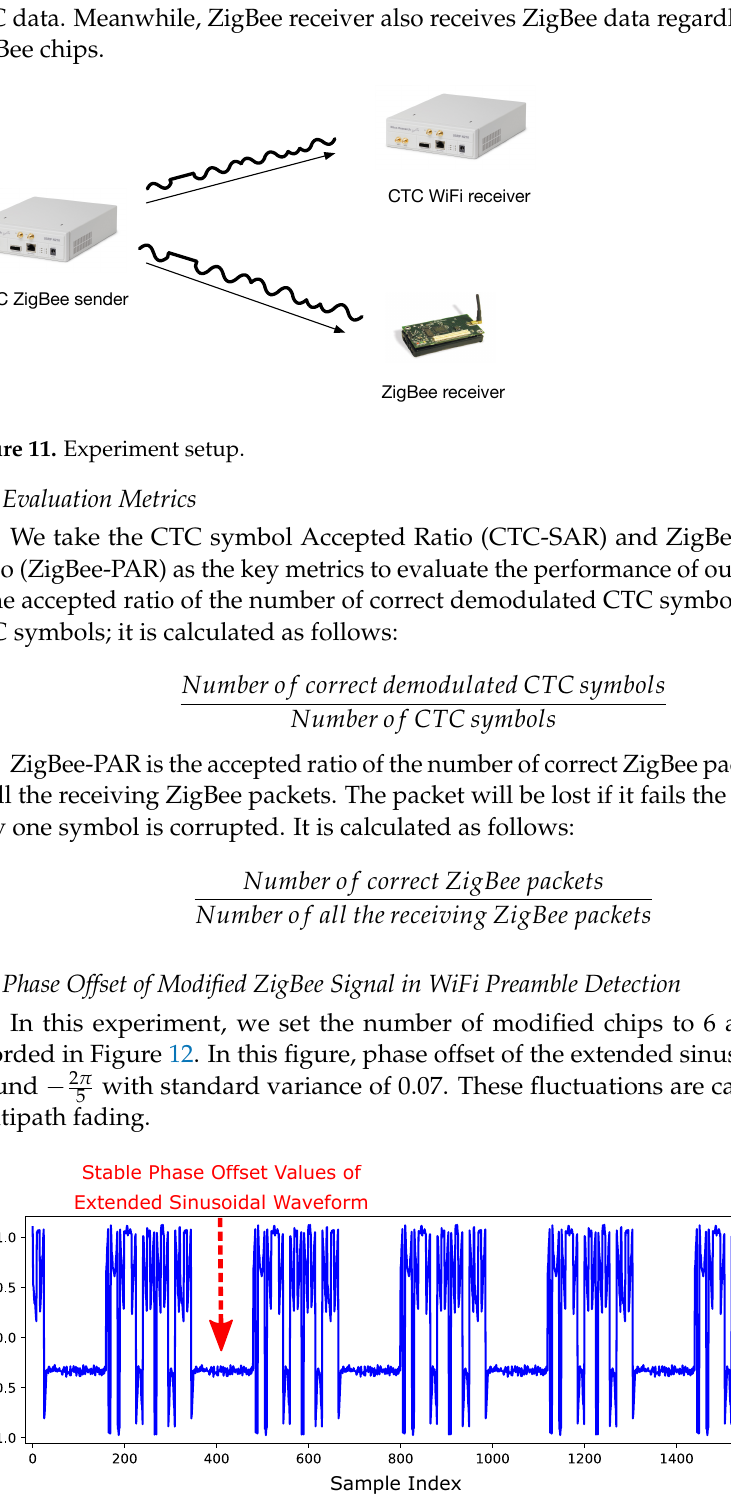
Figure 12. Phase offset of modified ZigBee signal in WiFi preamble